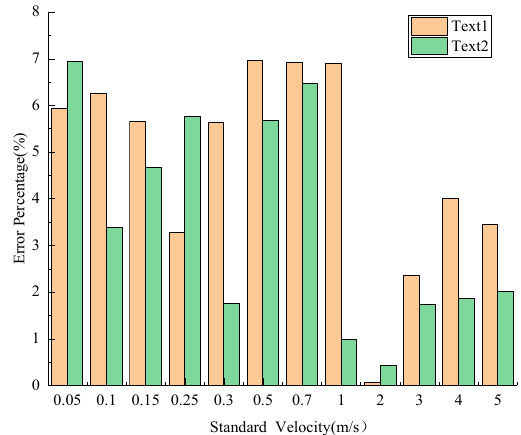
Figure 24. The comparison analysis of error